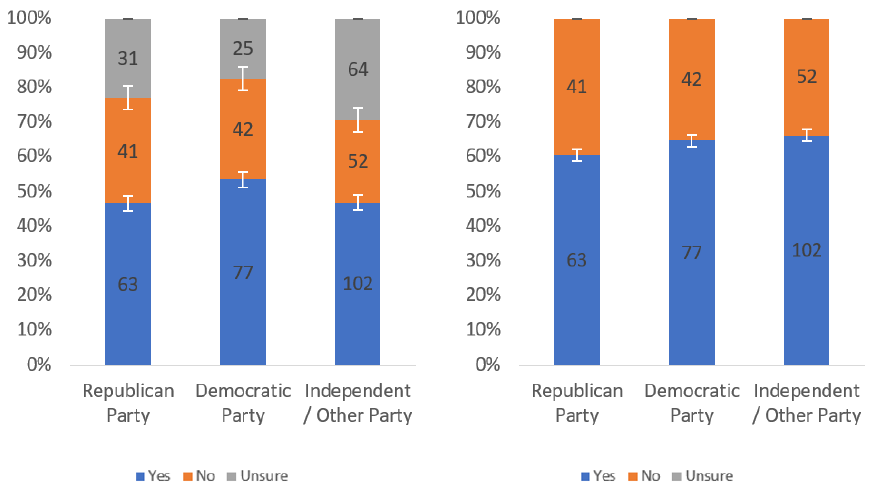
Figure 49. Responses regarding others’ willingness to review by political affiliation including ( left ) and excluding ( right ) unsure responses.